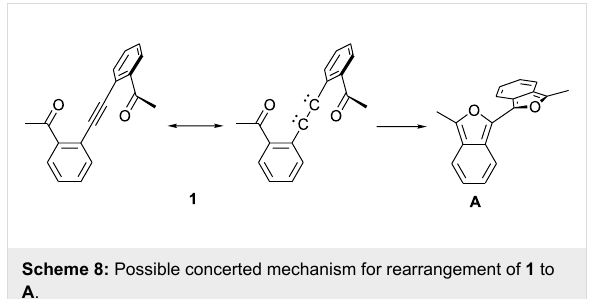
Scheme 8: Possible concerted mechanism for rearrangement of 1 to A